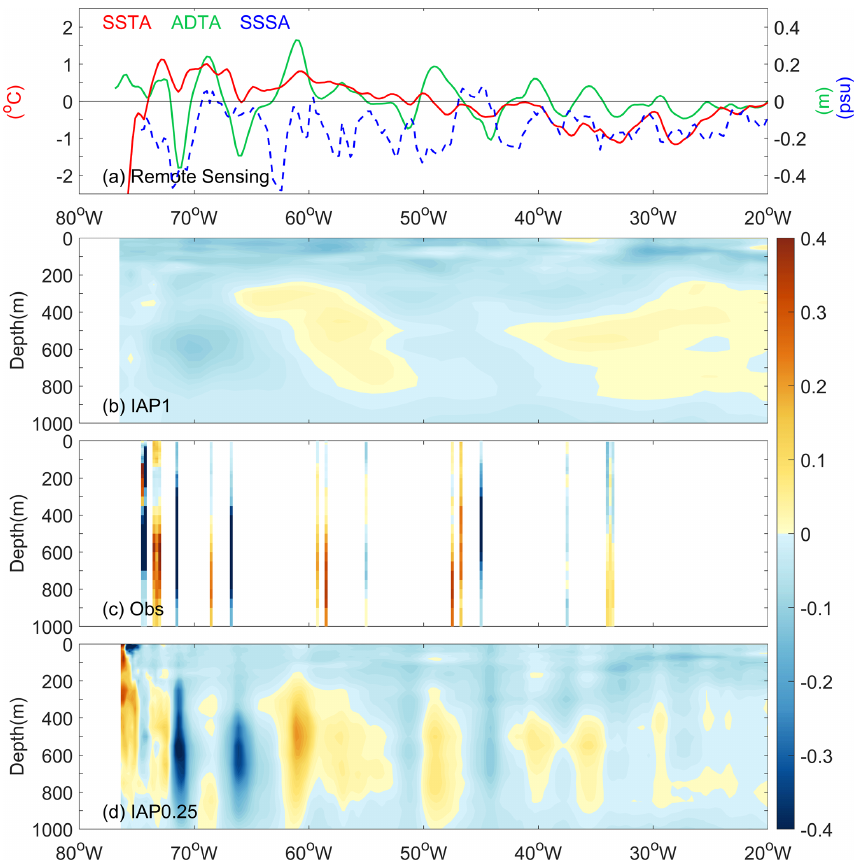
Figure 7. The distribution of SSTA (left y axis), ADTA, and SSS anomalies (SSSA) observed by SMAP on the sea surface (ADTA and SSSA share the right y axis), as well as the vertical section along 35.375 ◦ N of the observational in situ salinity anomalies, subsurface salinity anomalies from IAP1 ◦ , and IAP0.25 ◦ gridded data in the Gulf Stream